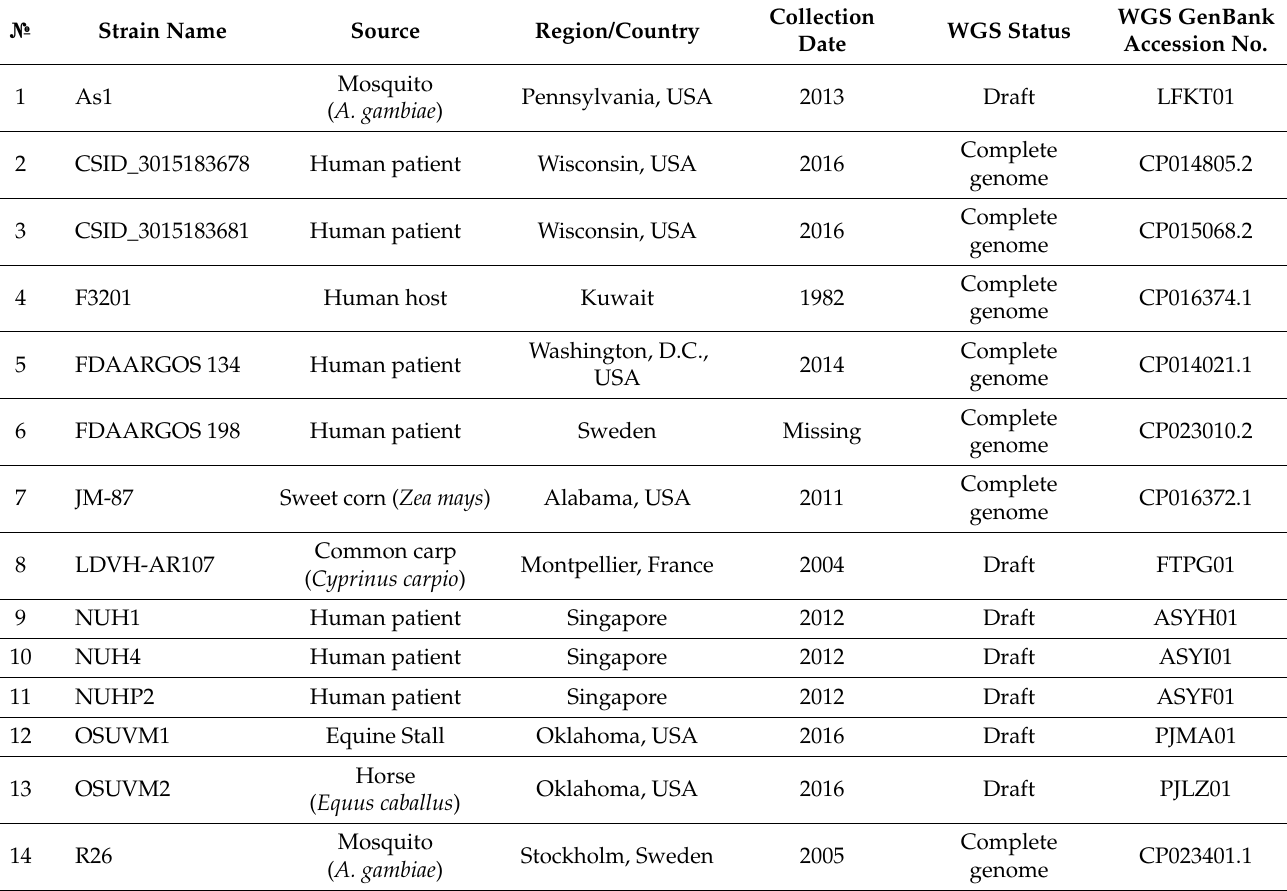
Table 3. Elizabethkingia anophelis strains used in this